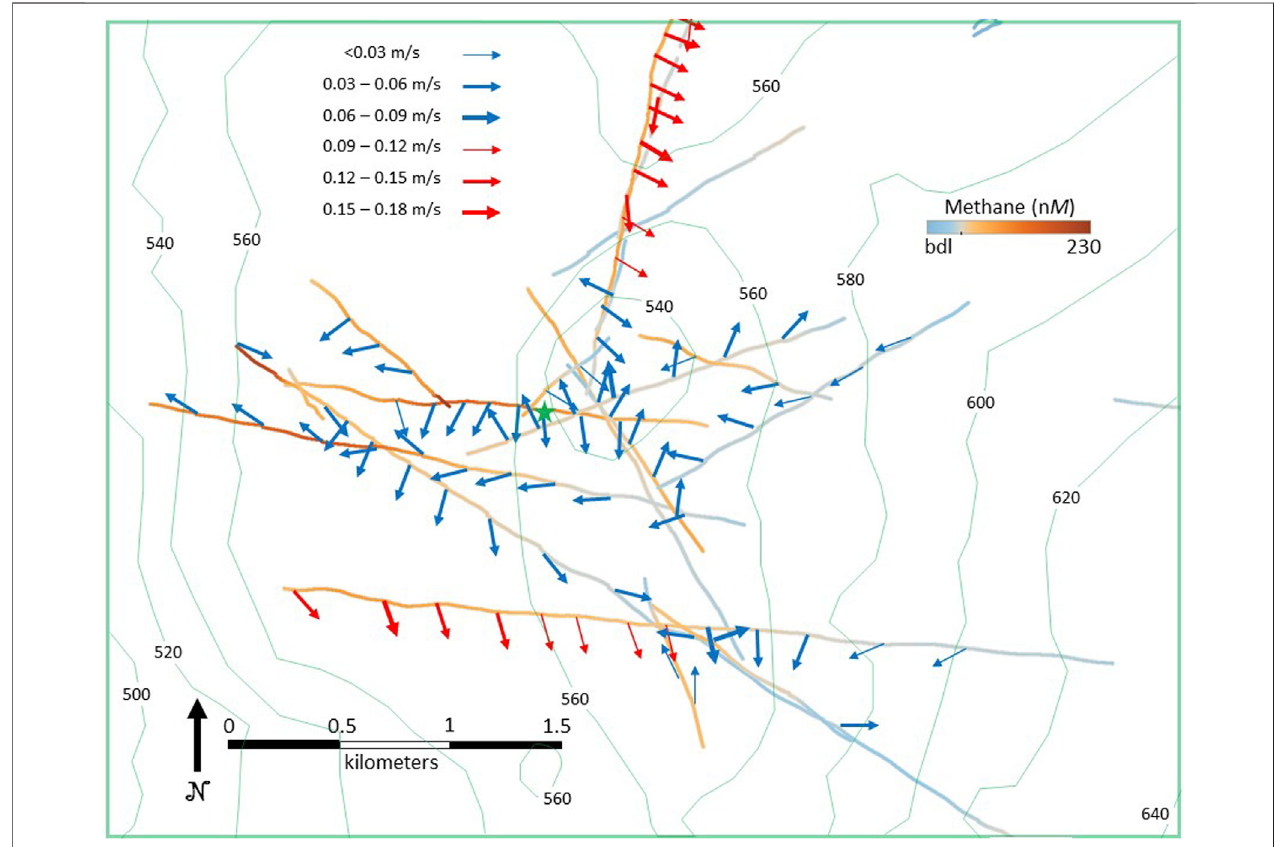
FIGURE11| Averagenear-bottomcurrentmeasurementsareshownasvectors(seelegend).Eachvectortailislocatedonthegliderpathforthatdatapoint.Glider paths are color coded to indicate the methane concentration with orange colors indicating con fi dent detection (see e.g., Figures 4 – 6 ). The green star represents the venting location for Bush Hill (27.7811 ° N, 91.5082 ° W). Bathymetry shown is in meters below sea level.